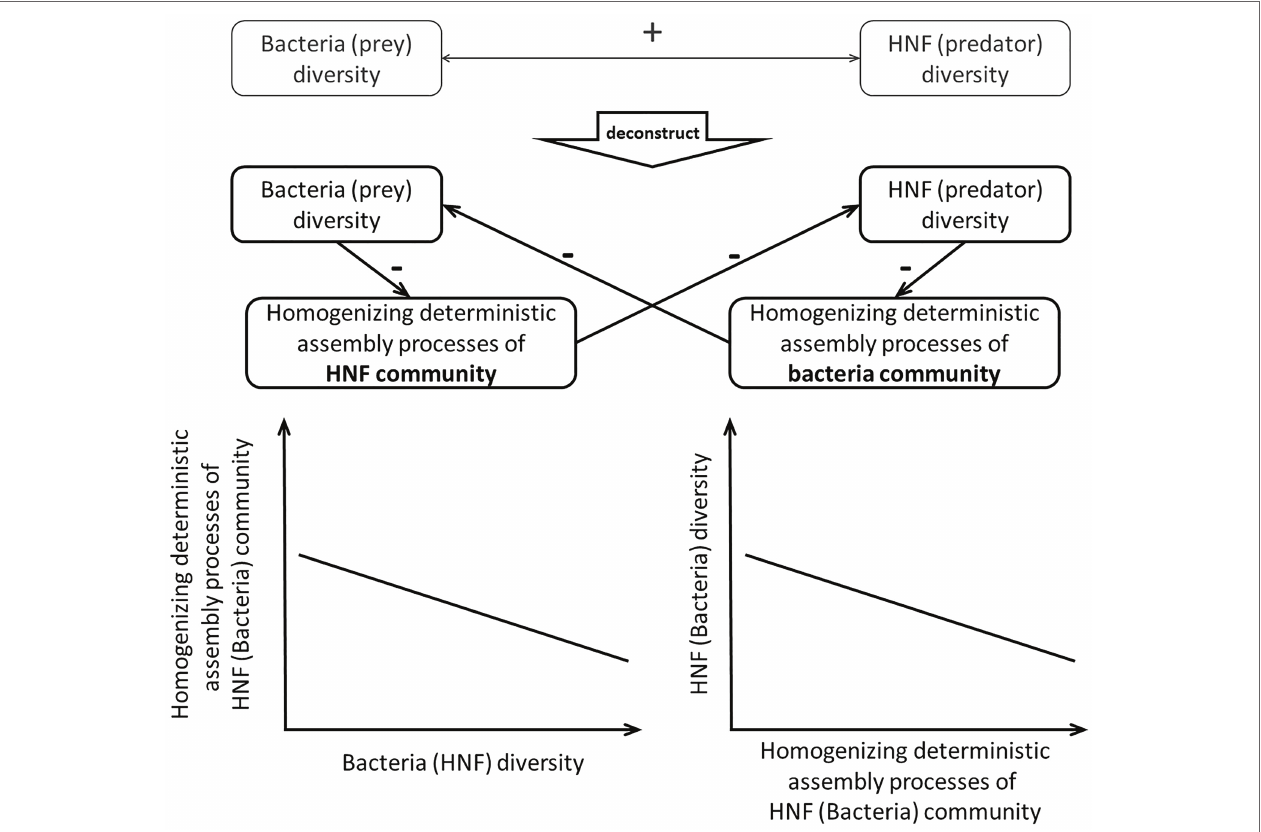
FIGURE 1 | Schematic plots visualizing the two-step analytical framework and the ensuing expectations. We argue that the positive HNF (predator)-bacteria (prey) diversity association can be caused by top-down and/or bottom-up control mechanisms. The top-down control mechanisms should cause the HNF α -diversity to weaken the homogenizing deterministic assembly processes of bacteria community and thus lead to higher bacteria α -diversity. On the other hand, the bottom-up control mechanisms should cause the bacteria α -diversity to weaken the homogenizing deterministic assembly processes of bacteria community and thus lead to higher HNF α